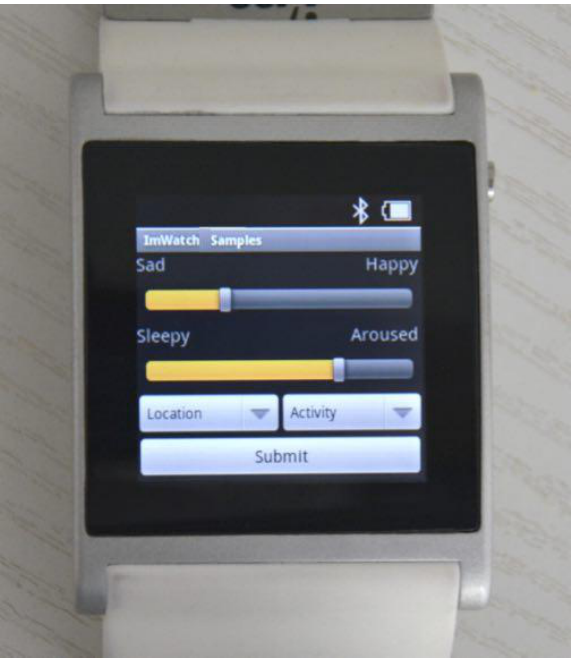
Figure 1. Smartwatch manual data collection